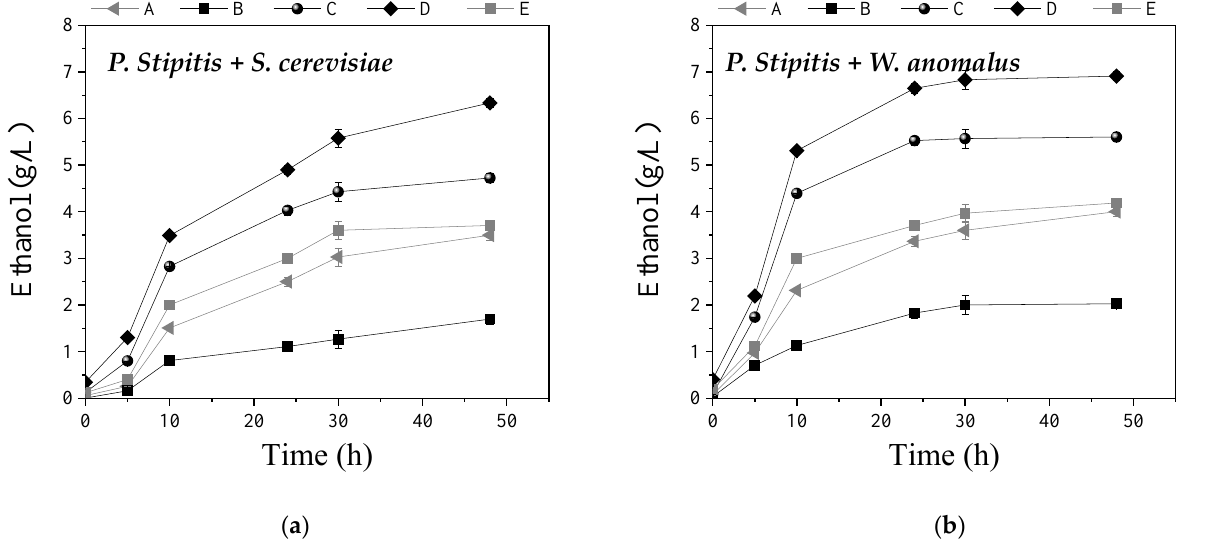
Figure 6. Ethanol concentration during batch co-culture of ( a ) Pichia stipitis and Saccharomyces cerevisiae , ( b ) Pichia stipitis and Wickerhamomyces anomalus X19 for the fermentation of the whole slurry after pretreatment with (A) NaOH (0.5% w / v ), (B) H 2 O 2 (0.5% v / v ), (C) mixture of NaOH (0.5% w / v ) and H 2 O 2 (0.5% v / v ) at ratio 1:1, (D) initially NaOH (0.5% w / v ) followed by H 2 O 2 (0.5% v / v ), and (E) initially H 2 O 2 (0.5% v / v ) followed by NaOH (0.5% w / v ).